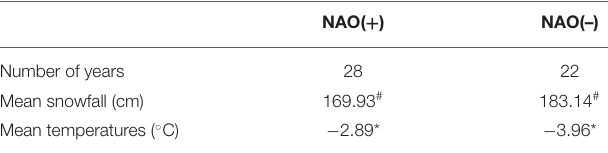
TABLE 4 | Impact of the ENSO on annual total snowfall in the LPM. TABLE 5 | Impact of the NAO on annual total snowfall in the